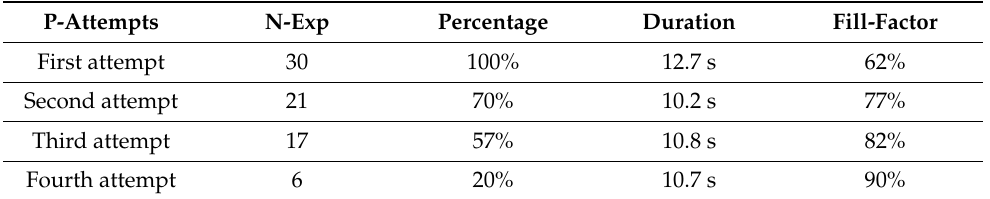
Table 5. Duration and fill factor in consecutive attempts. P-Attempts: progressive sequence of